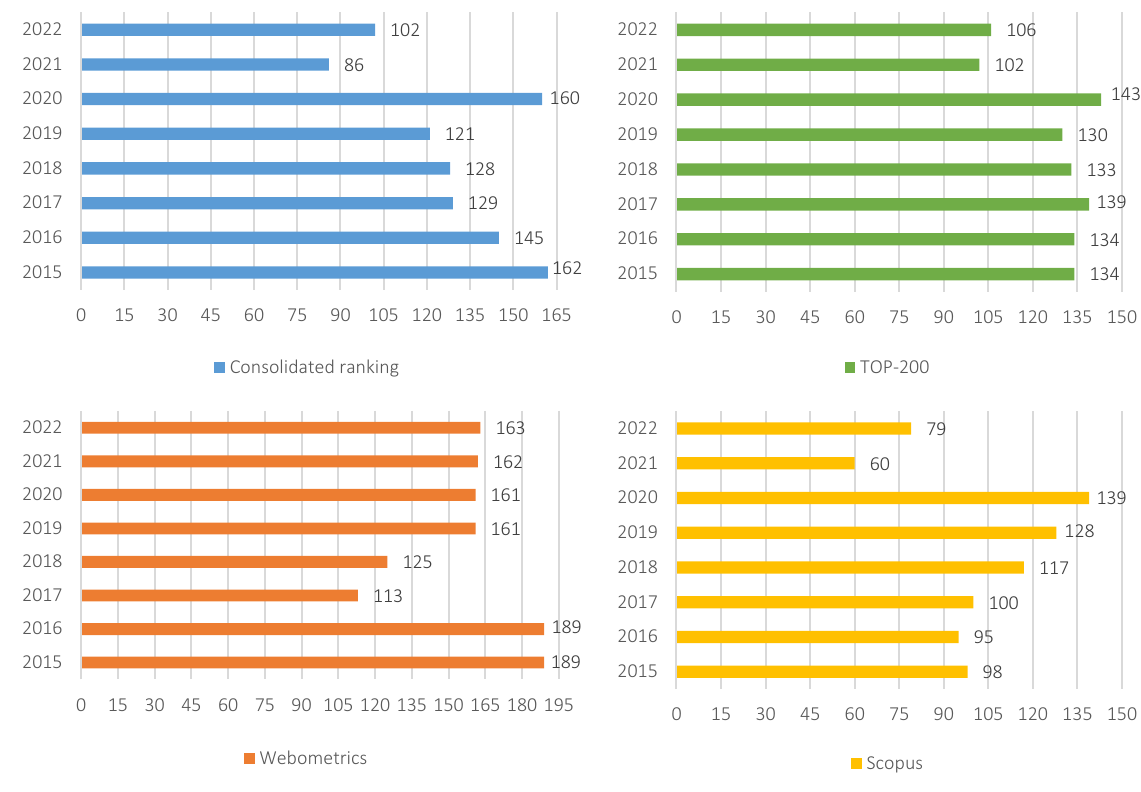
Figure 3. Dynamics of Cherkasy State Technological University in all-Ukrainian and international university rankings in